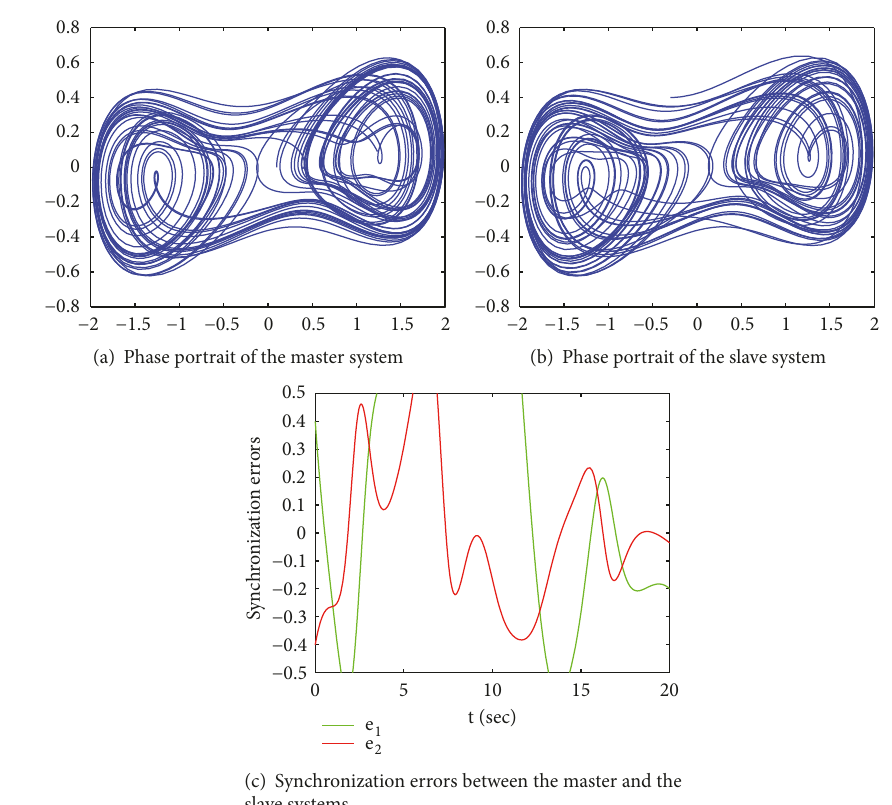
Figure 3: Behavior of the master-slave systems without control